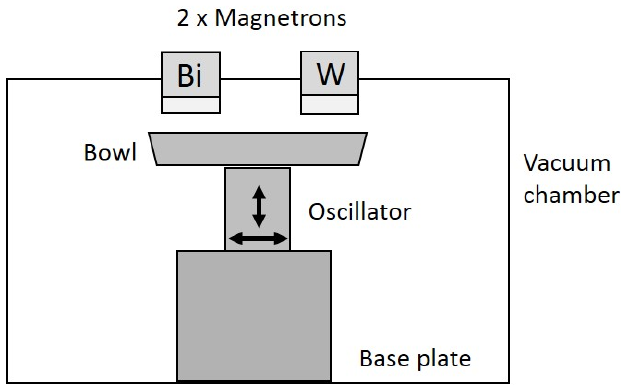
Figure 1. Schematic representation of powder coating sputtering rig in dual co ‐ planar configuration.